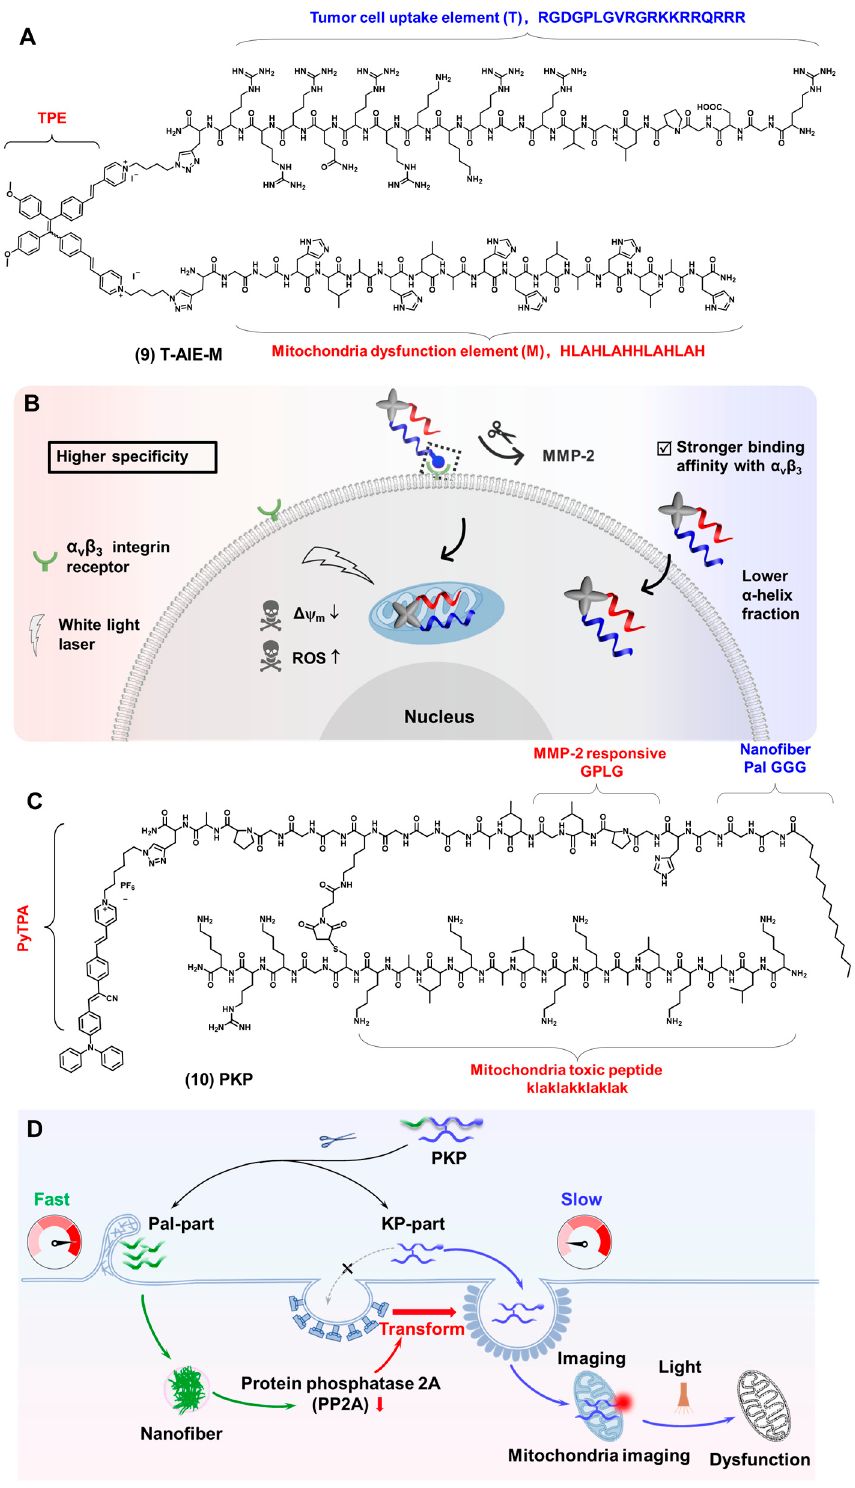
Figure 5 . ( A ) The chemical structures of T-AIE-M. ( B ) The schematic illustration of the two probes with different fluorescence imaging and tumor inhibition properties (this figure was adapted from [76] with some modifications). ( C ) The chemical structures of PKP. ( D ) The schematic illustration of PKP entering the cell, leading to mitochondrial damage (this figure was adapted from [77]).